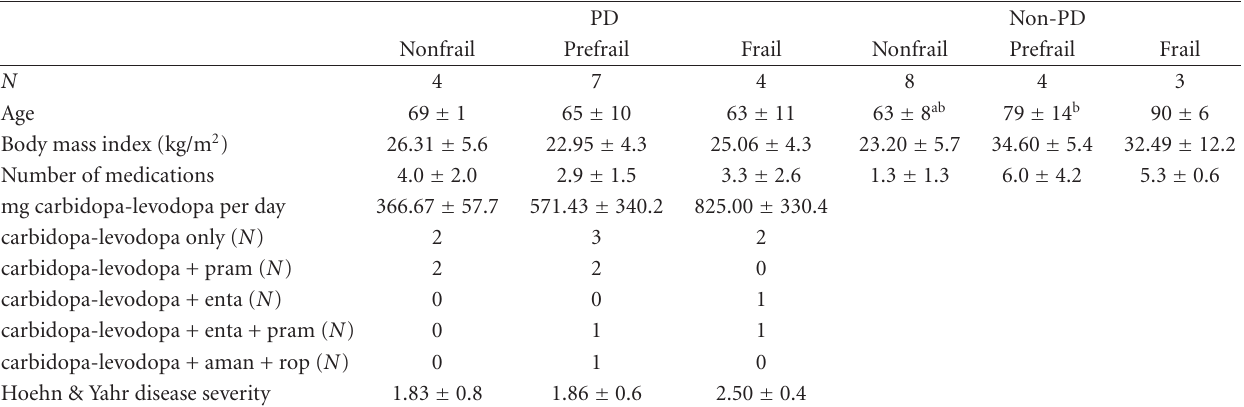
Table 1: Participant characteristics across frailty phenotypes in PD and non-PD females.